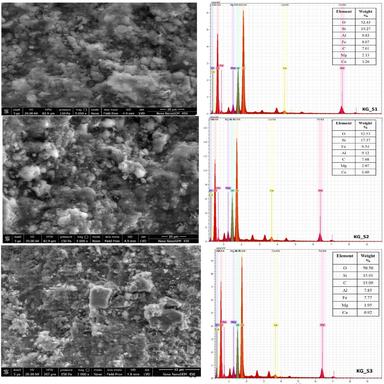
FESEM and EDX characteristics of KG Basin sediment Samples.